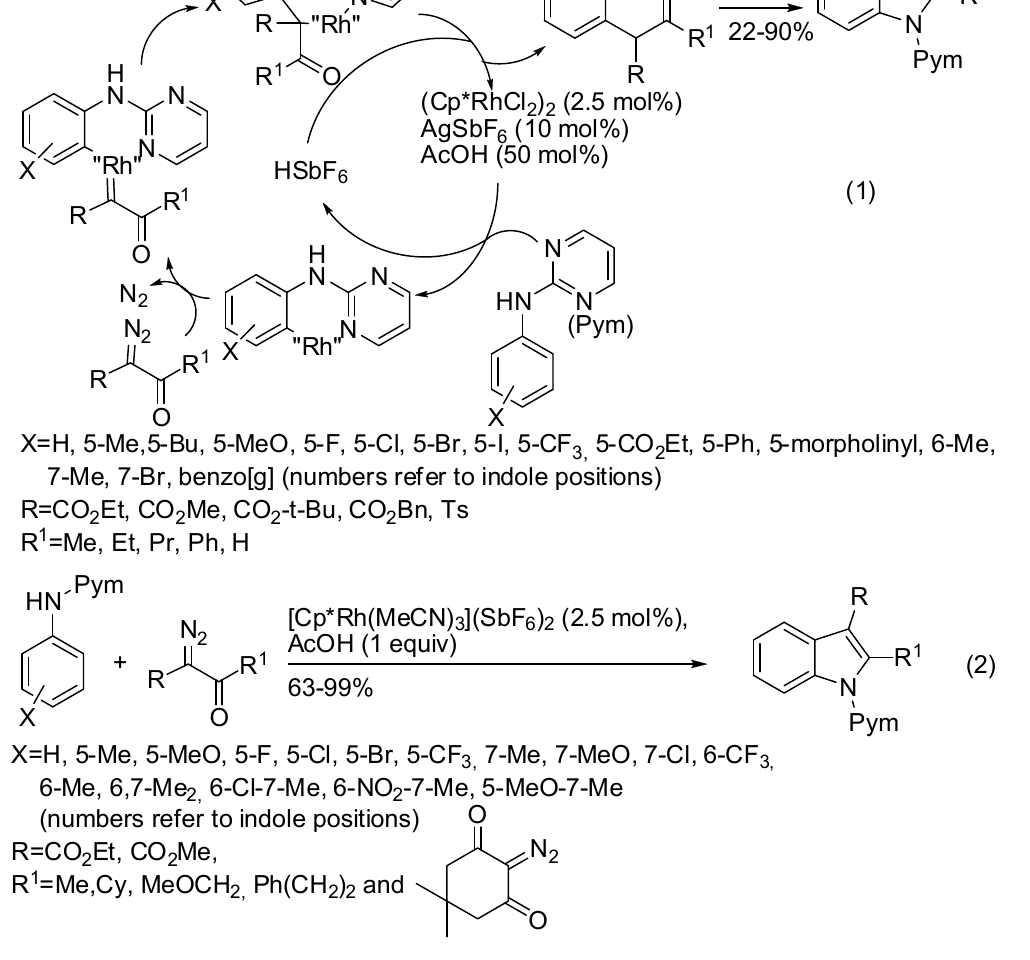
Scheme 52. Indole derivatives from pyrimidyl-substituted anilines and diazo compounds.